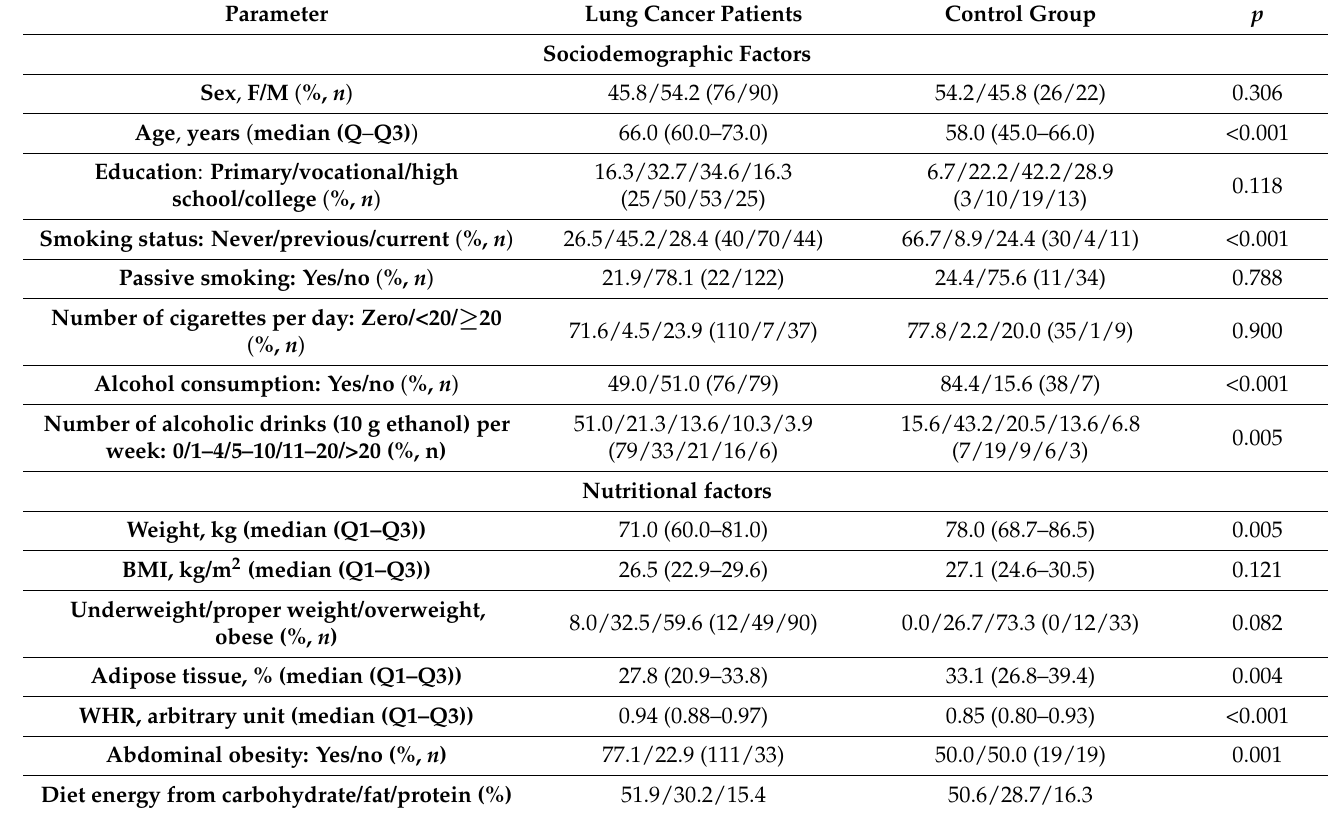
Table 1. Baseline characteristic of lung cancer patients and control